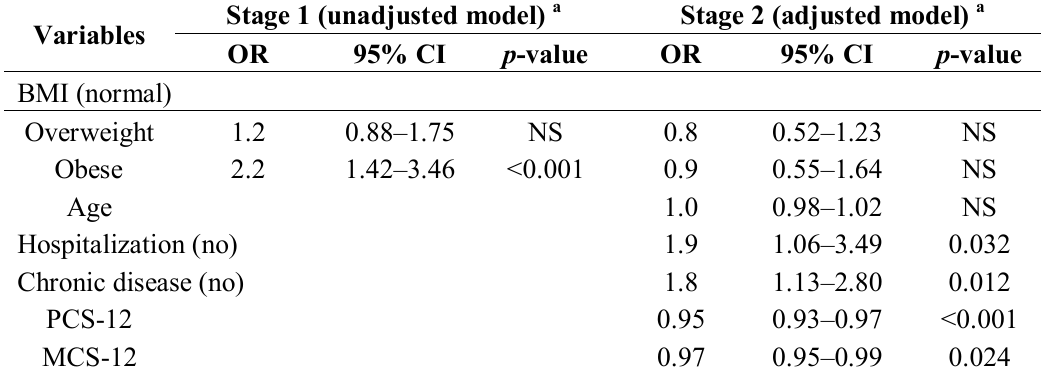
Table 4. Frequency of use (1–2 visits vs. 3 or more visits) according to logistic regression